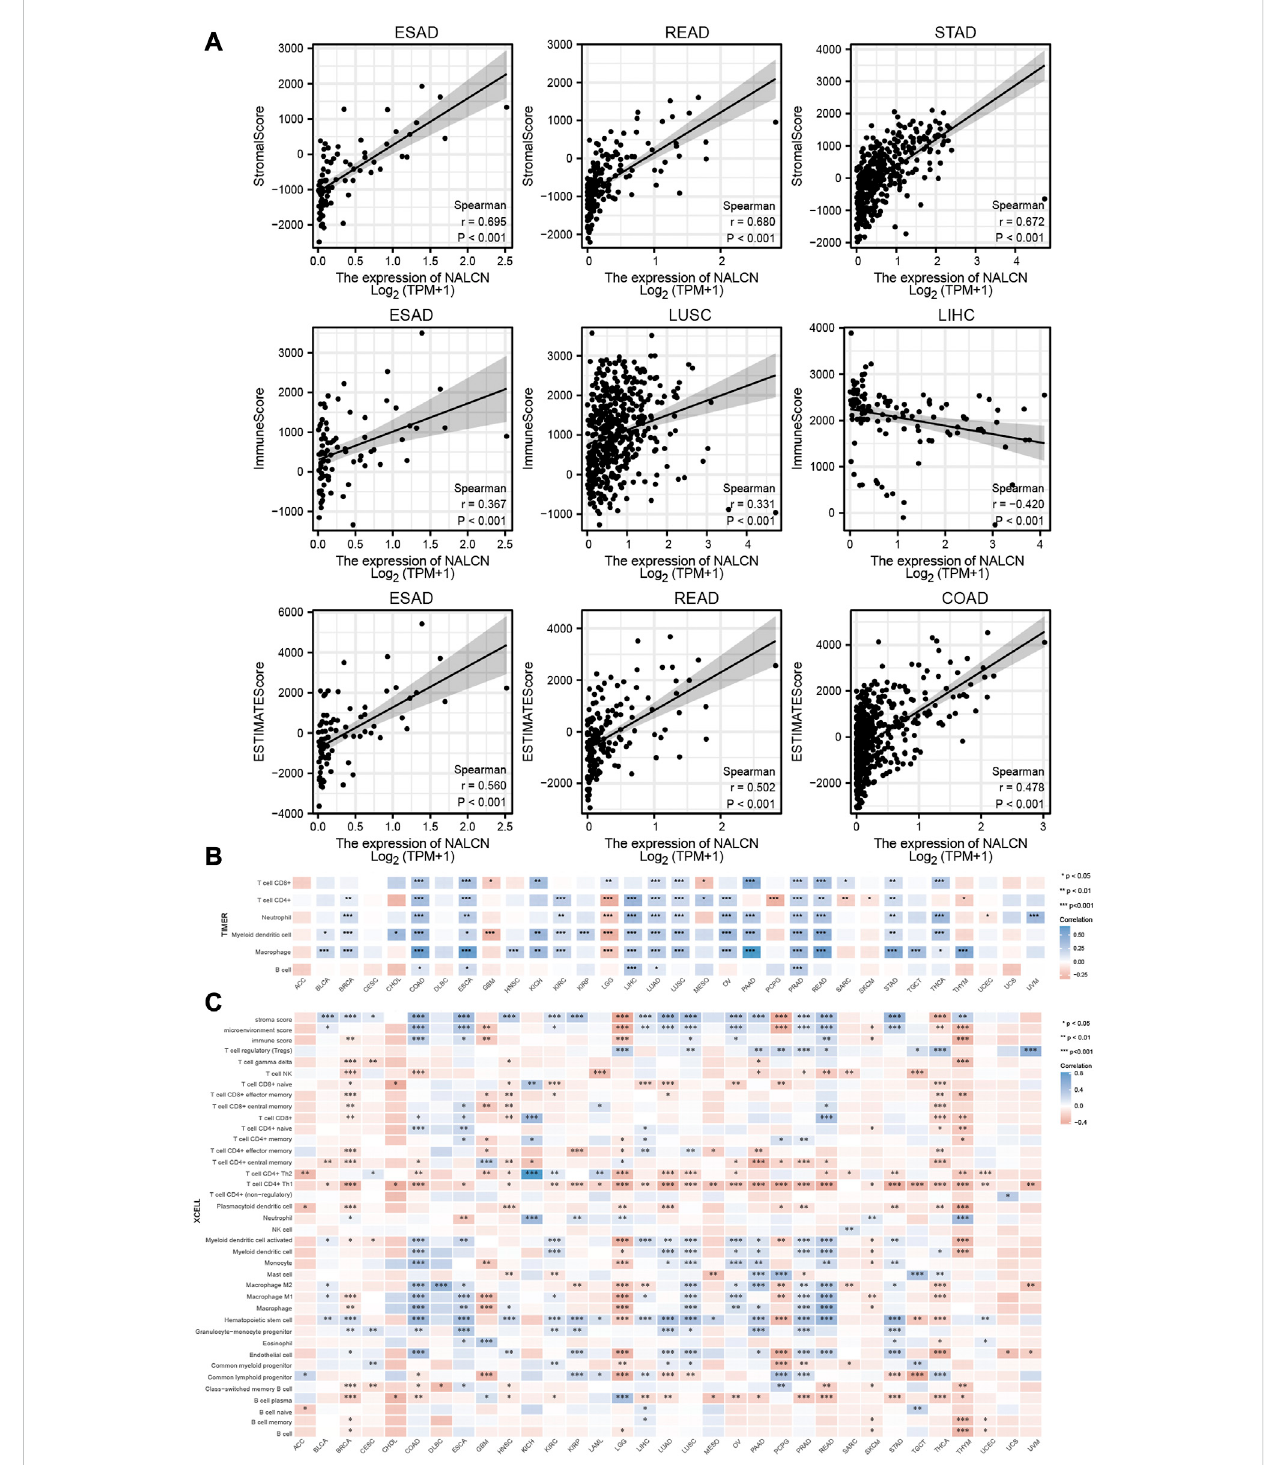
FIGURE 8 Relationship between NALCN expression and immune cell in fi ltration. (A) Top three scatter plots of correlation between NALCN and StromalScore, Immune Score, ESTIMATE Score in different cancers. (B) The correlations of NALCN and immune cell in fi ltration in cancers based on TIMER algorithms. (C) The correlations of NALCN and immune cell in fi ltration in cancers based on XCELL